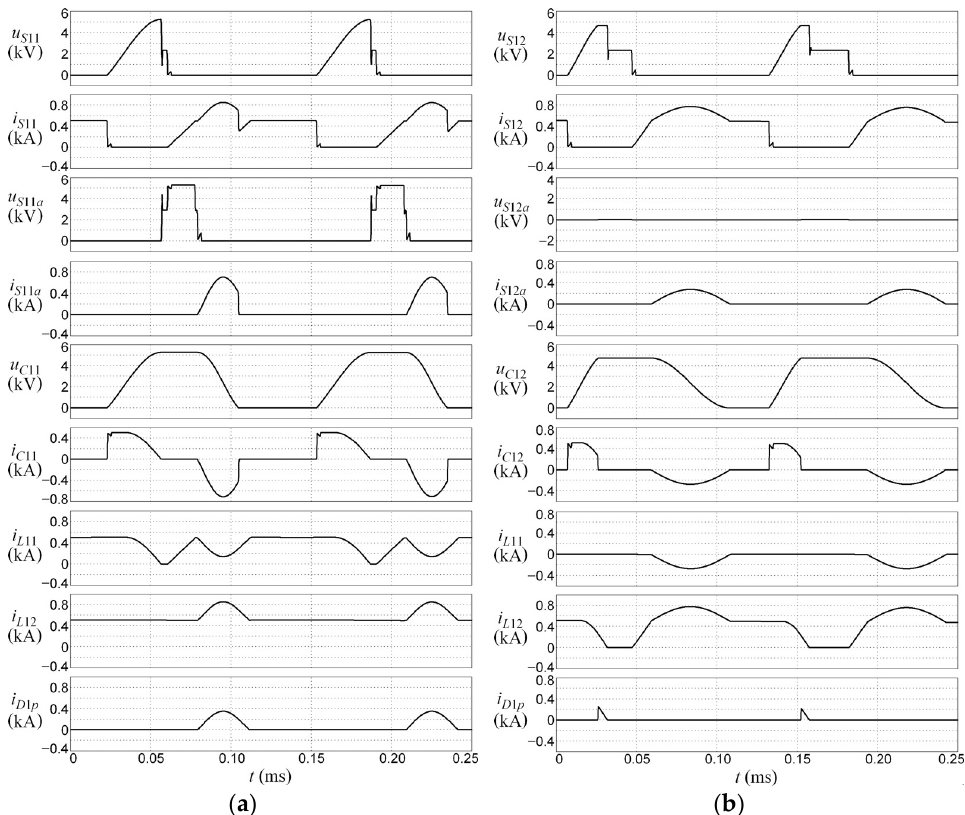
Figure 14. Waveforms during two switching cycles when the inverter supplied the induction motor: ( a ) S11 is switched ON/OFF, and ( b ) S12 is switched ON/OFF; switching frequency: 7.68 kHz.